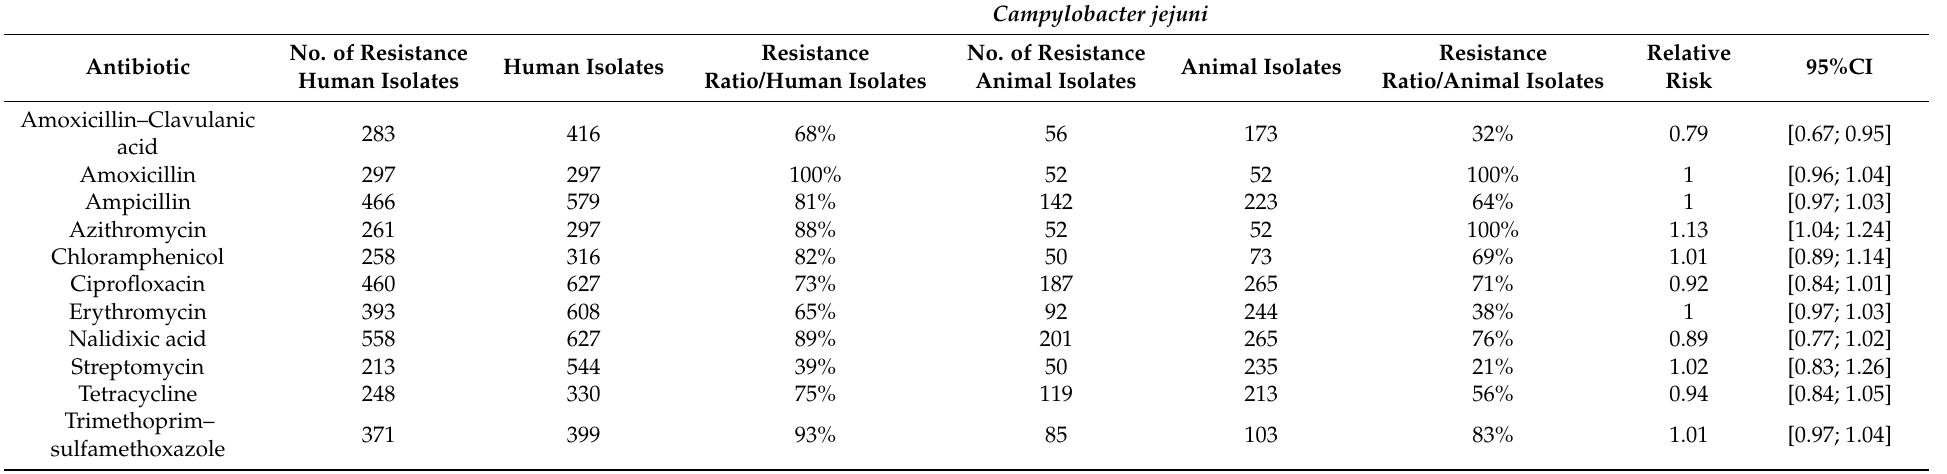
Table 4. Microbial resistance patterns detected by phenotypic screening among Campylobacter jejuni